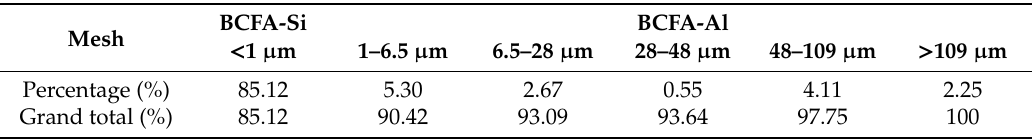
Table 3. Grain size distributions of BCFA-Si and BCFA-Al.